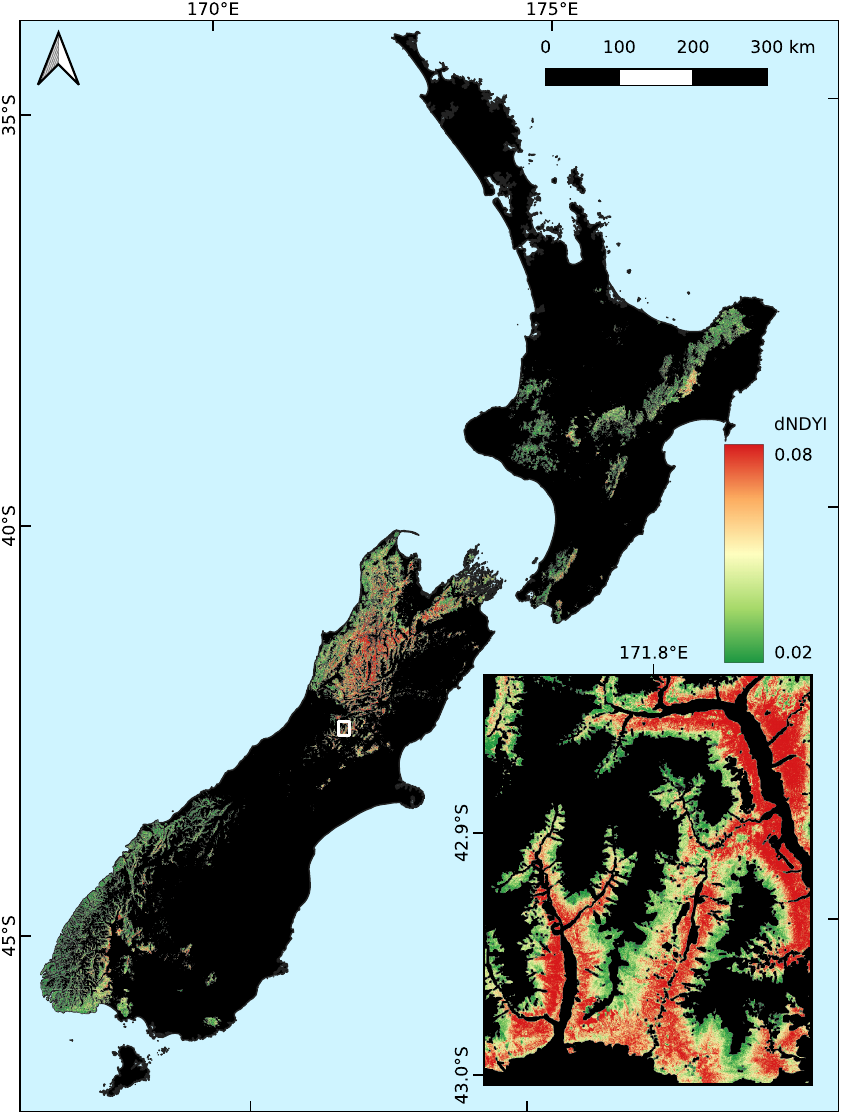
Figure 3. The maximum ∆ NDYI (from the model) for spring 2018 in areas of known southern beech forest in New Zealand. Green denotes areas of low (<0.02) maximum ∆ NDYI, while red is high (>0.08) and indicates heavy beech flowering. The inset shows the Hawdon and Poulter Valleys near Arthur’s Pass (1:250,000 at 42.95 ◦ S, 171.82 ◦ E; see white